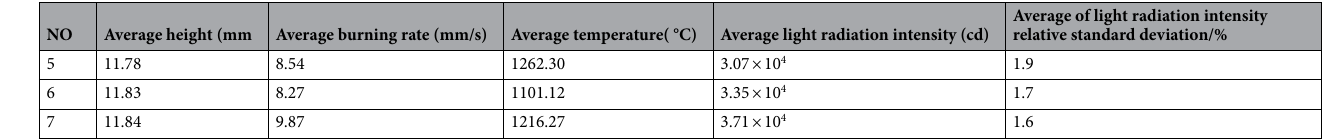
Table 4. Combustion characteristics of KClO 4 /Al with different metal